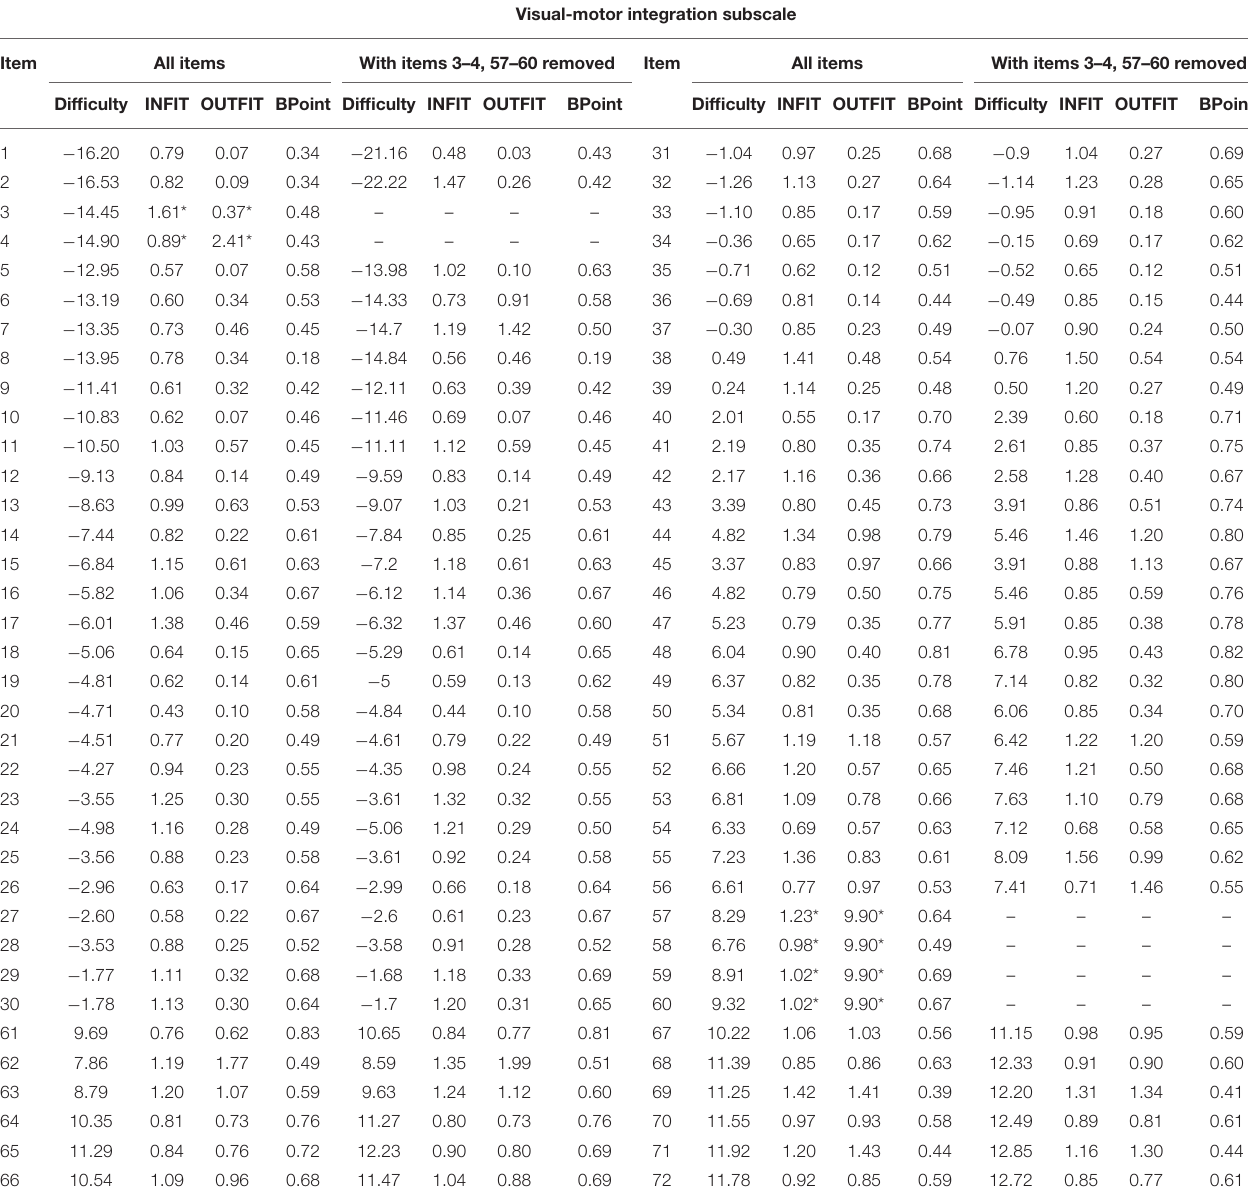
TABLE 7 | Visual-motor integration: item difficulty, INFIT, OUTFIT, and point-biserial correlations before and after removing